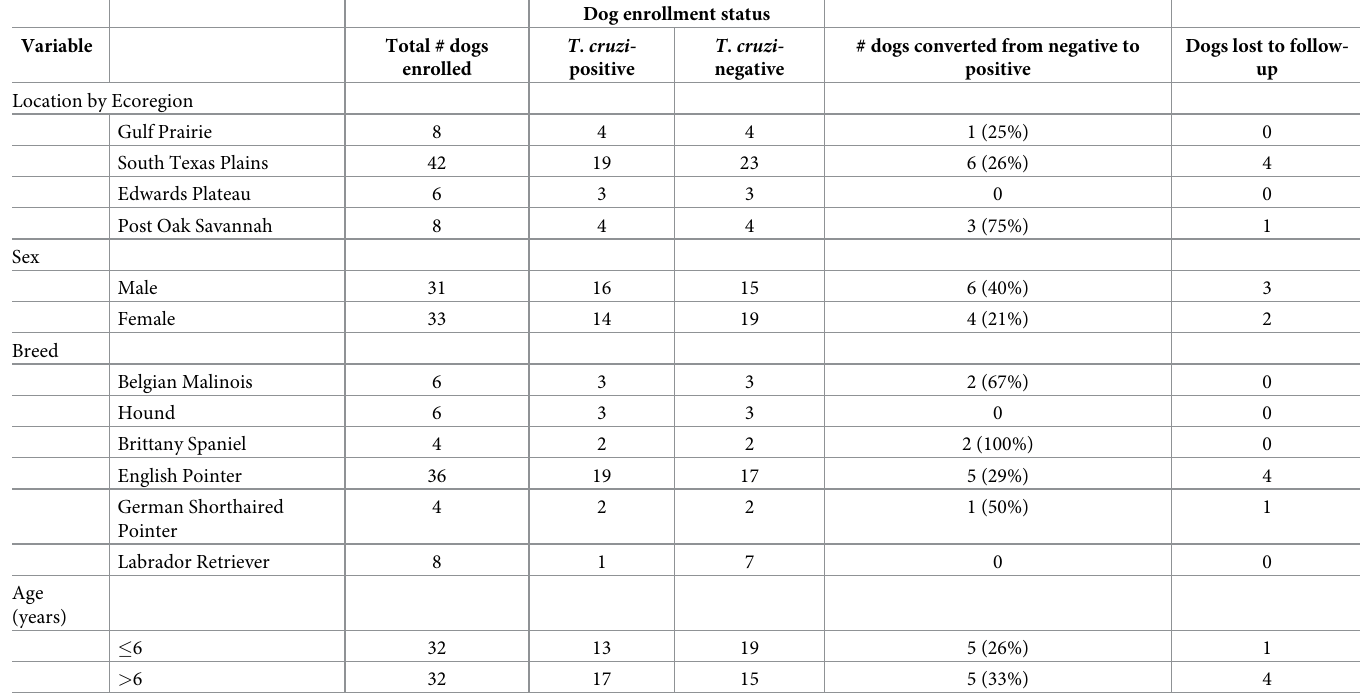
Table 1. Location, demographic data, and T . cruzi infection status of dogs at the time of enrollment, with data on new T . cruzi infections.